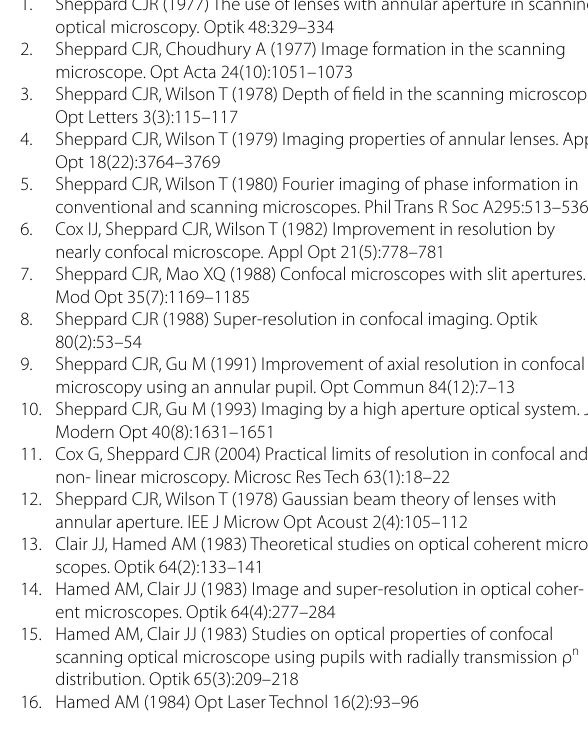
16 pixels. The cutoff radial distance ( r c ) =